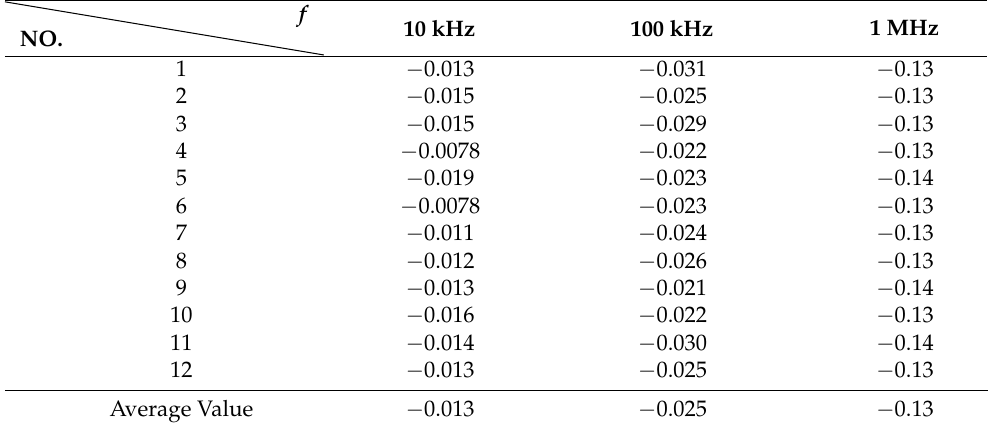
Table 2. Relative errors of RMS measurement